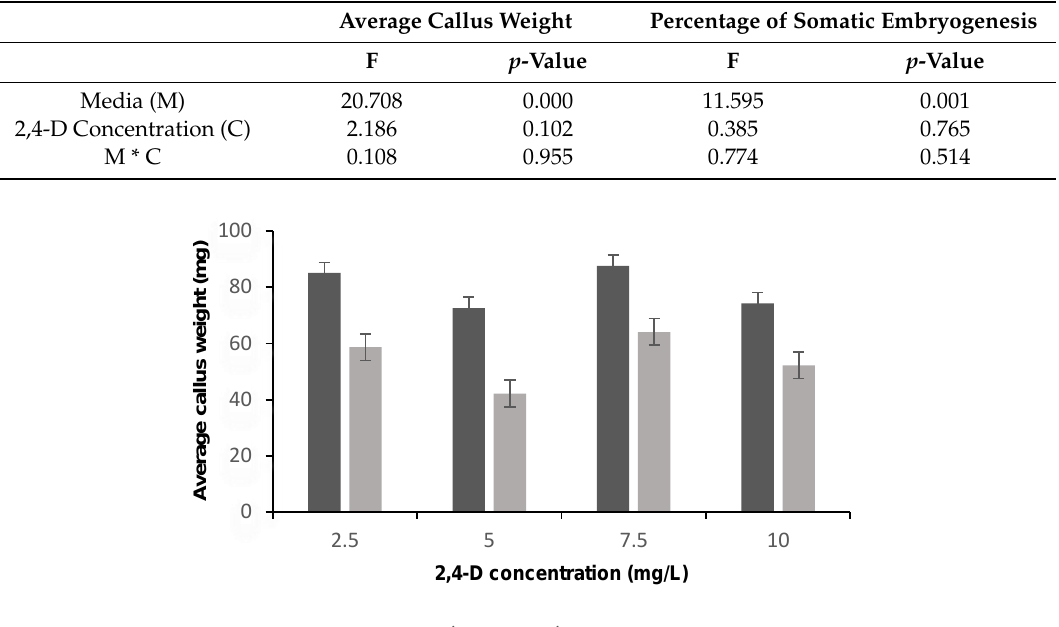
Table 1. Analysis of variance of the e ff ect of media, 2,4-D concentrations and interaction between media and 2,4-D concentration on the average callus weight and percentage of somatic embryogenesis for induction of somatic embryogenesis in Eksotika.